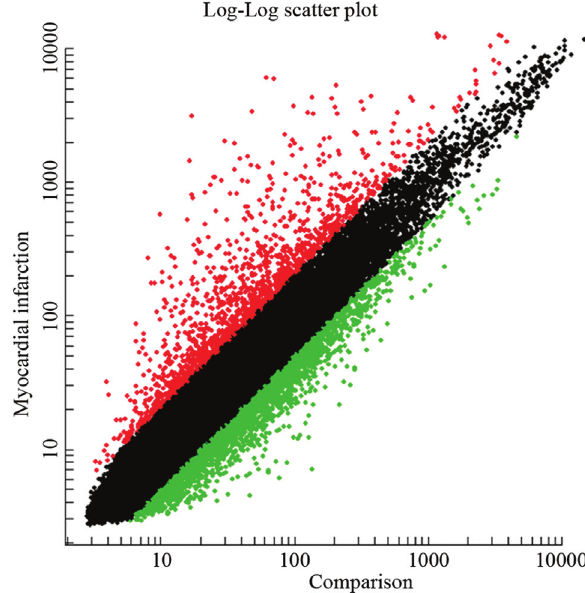
Figure 1 - Scatterplot of differentially expressed genes between AMI and healthy people.